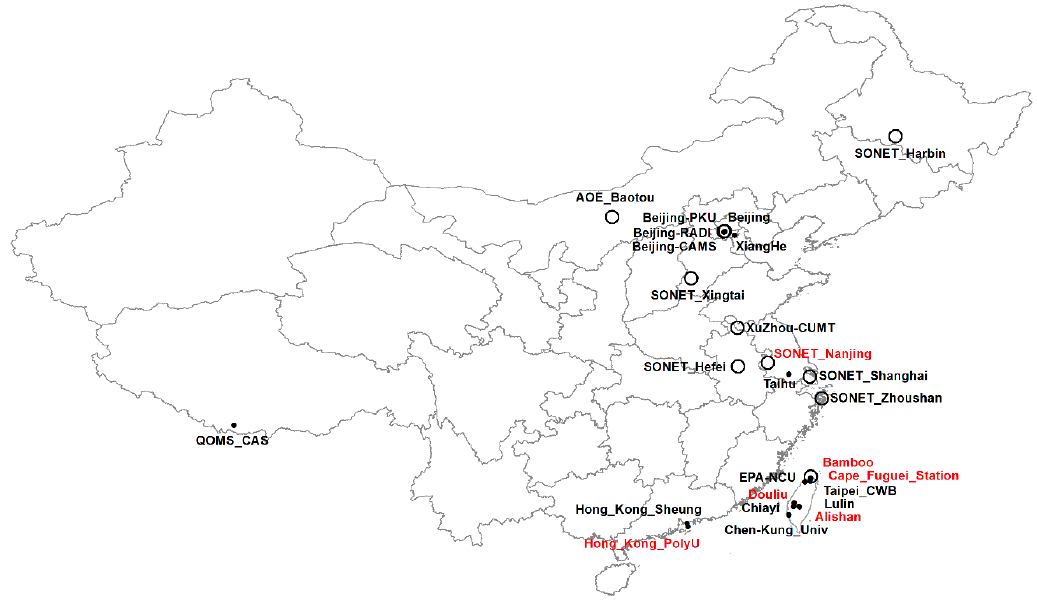
Figure 1. Locations of 26 urban AERONET sites with Level 1.5 data (open circles, 11 sites) and with both Level 1.5 and Level 2.0 data (small solid circles, 15 sites) in 2016. The six sites shown in red were not used because they had no contemporaneous AERONET and satellite data after application of the stringent filtering criteria described in Section 3.2. Table 1. The 26 urban AERONET site (Figure 1) short names, geographic locations, and 2016 AERONET data availability. The coordinates of the Landsat-8 images (path/row) and Sentinel-2A tiles (tile ID) and 2016 data availability at each AERONET site are also summarized.